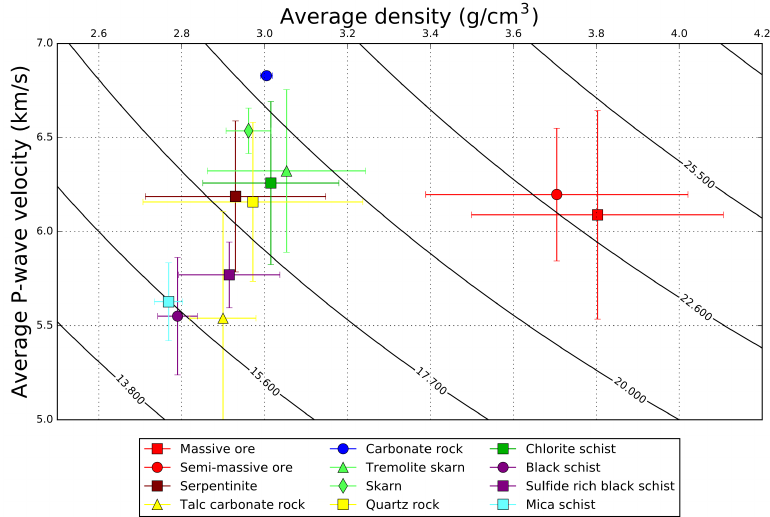
Figure 2. Results of petrophysical laboratory analysis of rock samples from the Kylylahti mine area (modified after [49]). Error bars indicate respective standard deviations. Contour lines denote the P-wave (acoustic) impedance. The line spacing corresponds to a reflection coefficient of 0.06, which is necessary to produce a detectable reflection